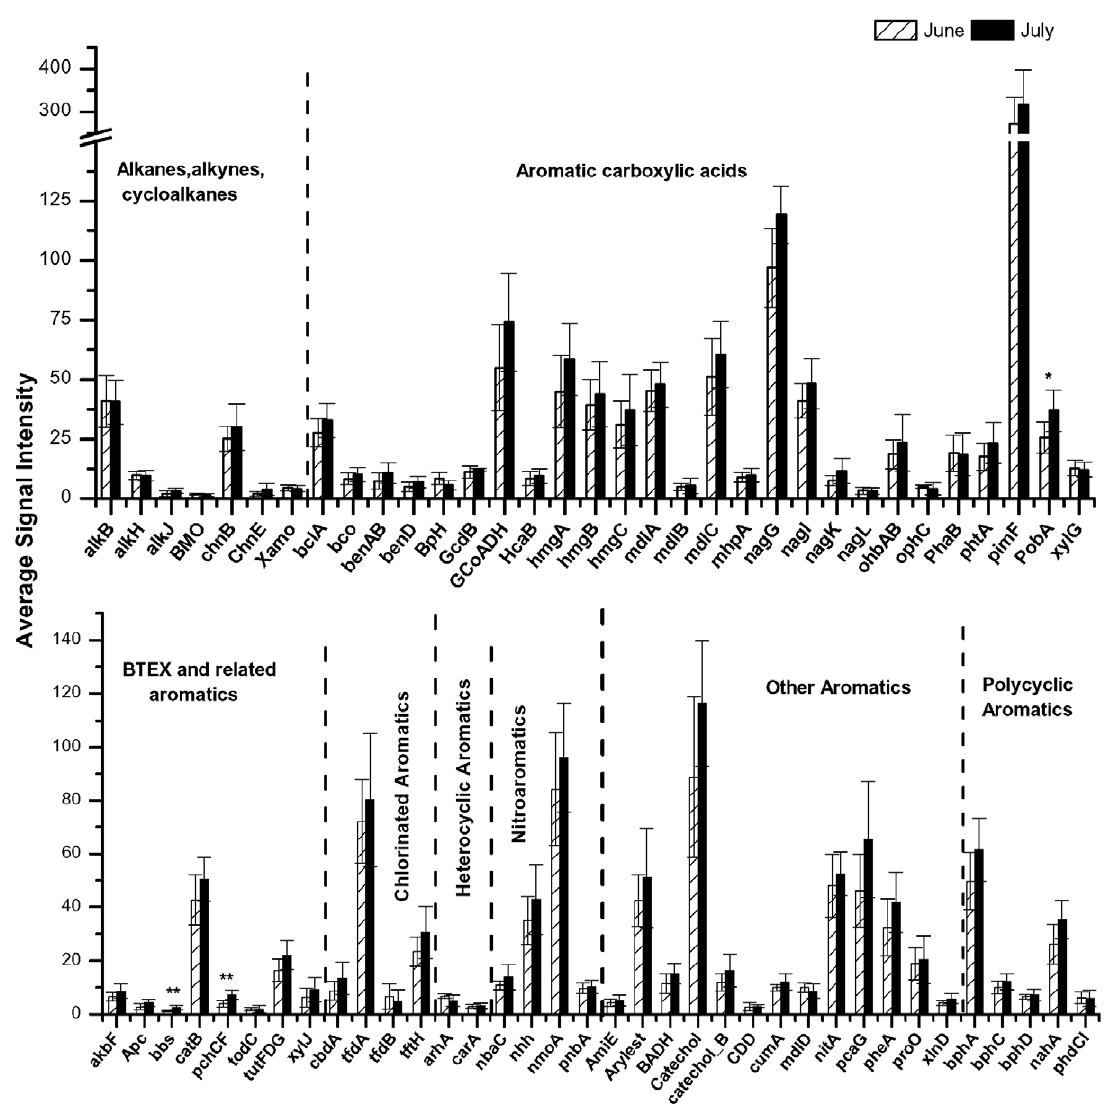
Figure 7. Hydrocarbon degradation genes in Inlet sediments. Average abundances of hydrocarbon degradation genes in Inlet sediments compared between June and July. Significant changes indicated by *for p , 0.05 and **for p , 0.01.